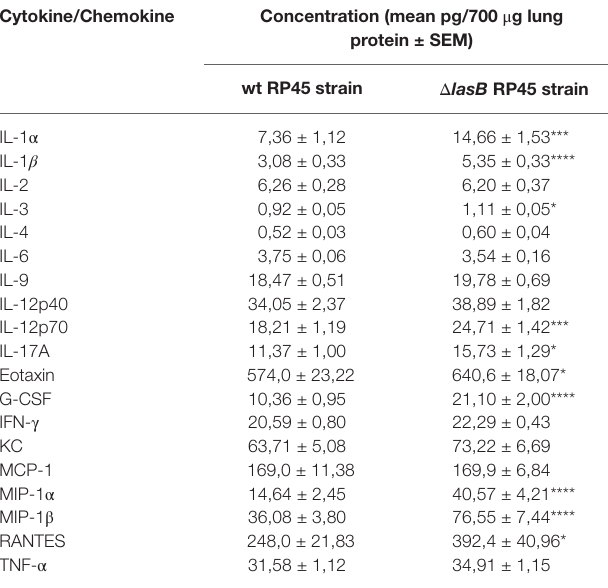
TABLE 1 | Cytokine/chemokine concentrations following chronic airway infection by wt and ΔlasB RP45 strains. Cytokine/Chemokine Concentration (mean pg/700 μ g lung protein ±